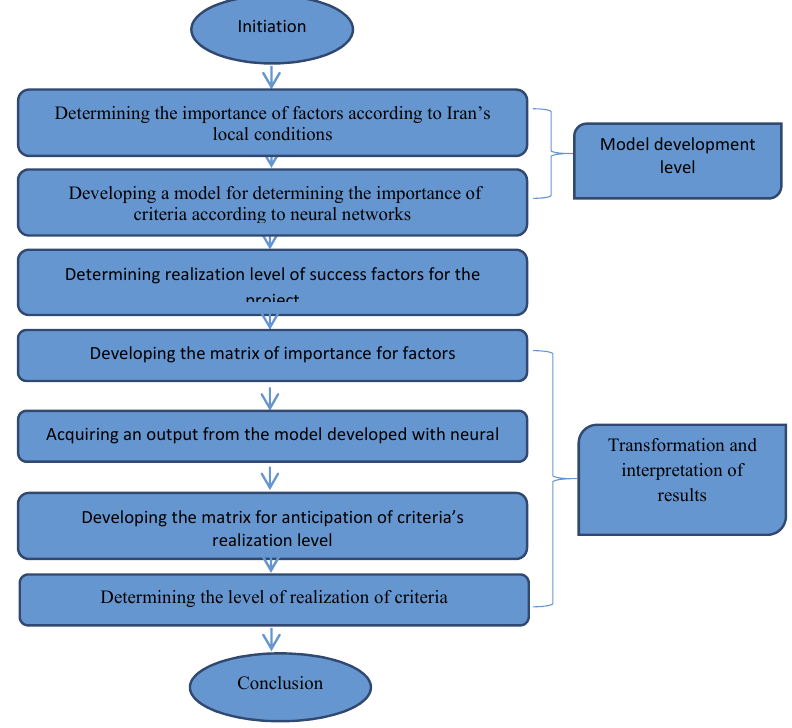
Fig. 2 . Flowchart of levels of the proposed model